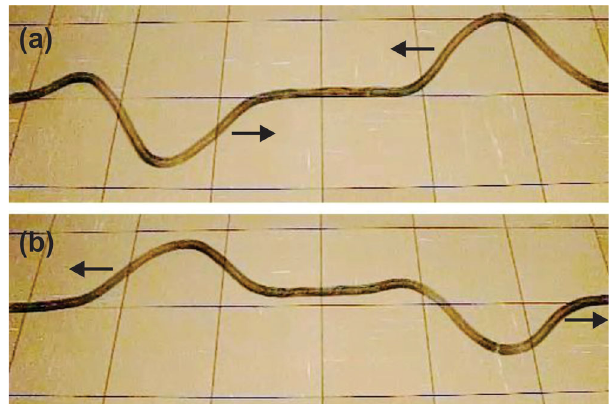
FIG. 3. Outcome of the second testing experiment, sending two opposite-sign pulses towards each other. Snapshots of the two pulses (a) before and (b) after they